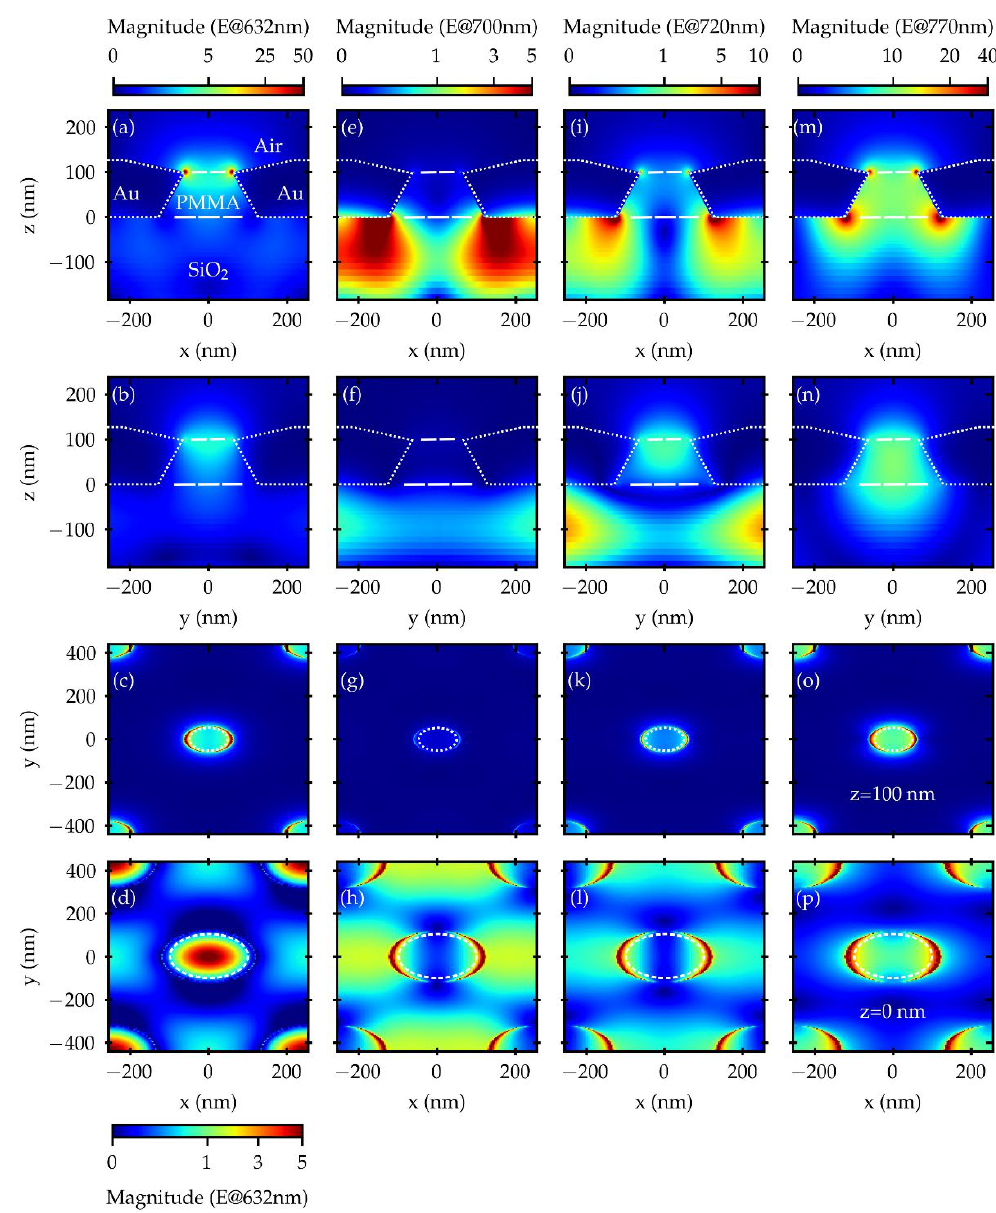
Figure 5. Electric field expansion in the PMMA nanopillar proximity region calculated with Ansys FDTD Lumerical software for different wavelengths: 632 nm (panels ( a – d )), 700 nm (panels ( e – h )), 720 nm (panels ( i – l ) and 770 nm (panels ( m – p )). Panels ( c , g , k , o ) and panels ( d , h , l , p ) refer to the EF expansion calculated at the nanopillar top (z = 100) and bottom (z = 0 nm), respectively. It is worth emphasizing the change in the magnitude scale corresponding to panel ( d ) with respect to panel ( c ).